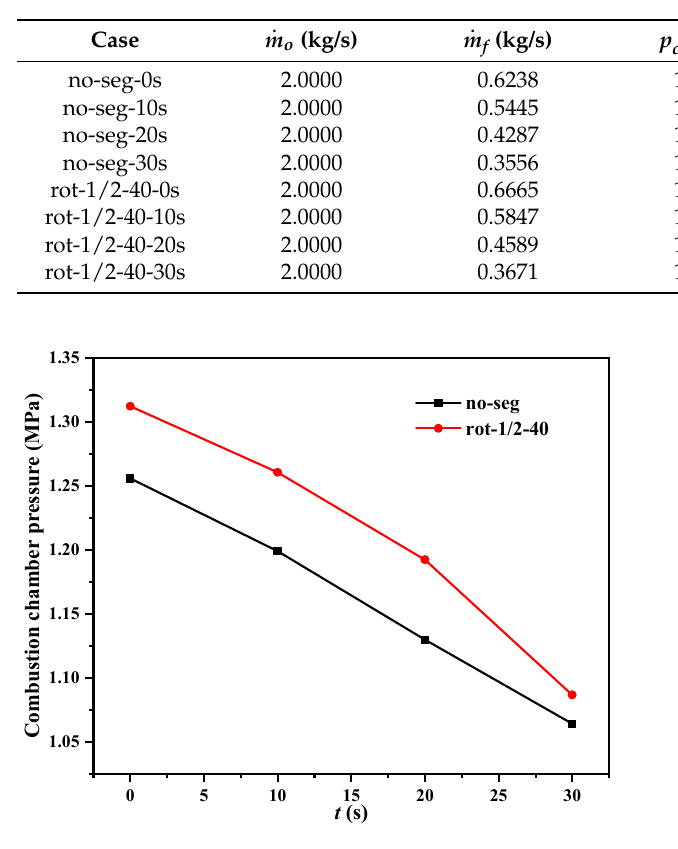
Figure 32. Combustion chamber pressure history in cases no-seg and rot-1/2-40.